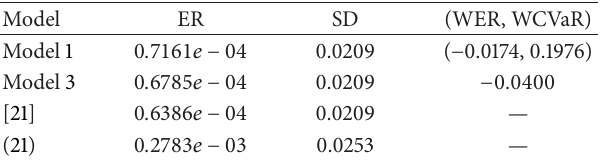
Table 2: Numerical results for Example 2 ( 𝜎 1 = 𝜎 3 = 0.2